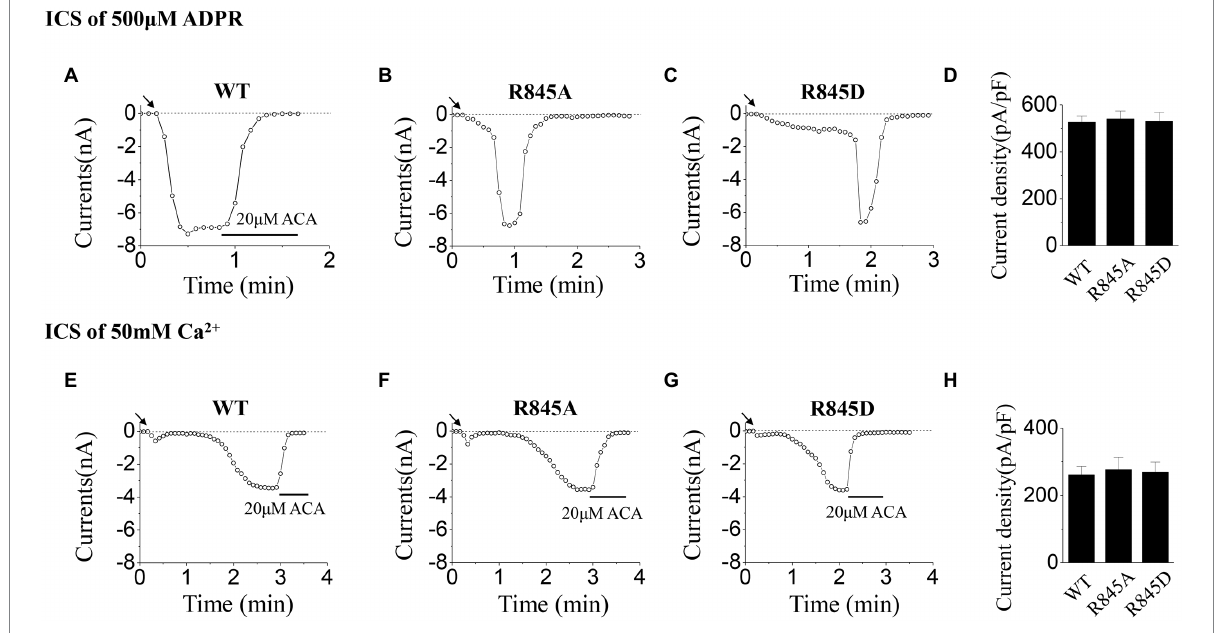
FIGURE 6 Functional assay of WT TRPM2 and mutants at R845. (A–C) Representative whole-cell recordings of TRPM2 channel currents induced by ICS of 500 μ M ADPR from HEK293T cells expressing (A) WT, (B) R845A, (C) R845D, and (D) Summary of the current density induced in cells expressing WT and mutants. In each case, six cells were tested. (E–H) Representative whole-cell recordings of TRPM2 channel currents induced by ICS of 50 mM Ca 2+ from HEK293T cells expressing (E) WT, (F) R845A, (G) R845D, and (H) Summary of the current density induced in cells expressing WT and mutants. The arrow in each panel indicates the time point at which whole cell configuration was established. In each case, six cells were